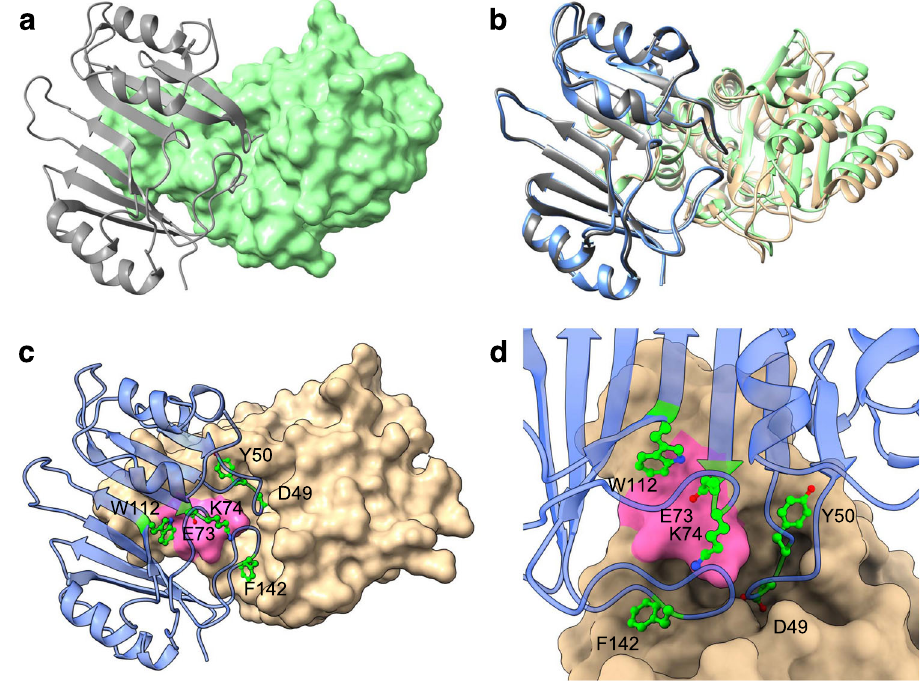
c StructureofBLIP(blue)bindingtoCTX-M-15 β -lactamase(tan).KeyBLIPresidues that interact with CTX-M-15 are shown in ball and stick (green) and labeled. The 103 – 106loopregionofCTX-M-15ishighlightedinpink. d BLIP/CTX-M-15activesite region rotated clockwise 90° from view in c